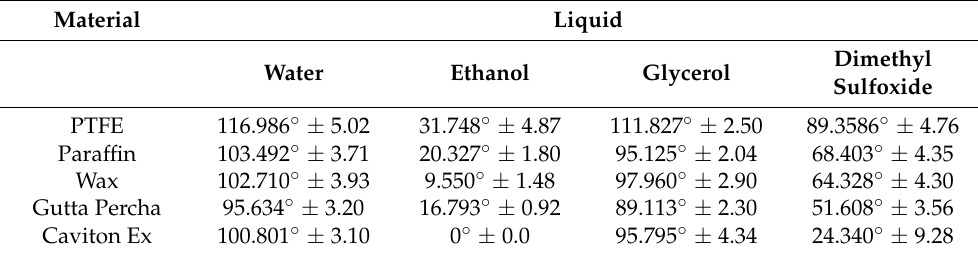
Figure 3. Image of the contact angle from a water sessile drop onto the materials. ( A ) PTFE, ( B ) paraffin, ( C ) wax, ( D ) gutta percha, and ( E ) caviton ex. Table 2. Contact angle measurements of materials from the sessile liquid drop test ( n = 25).